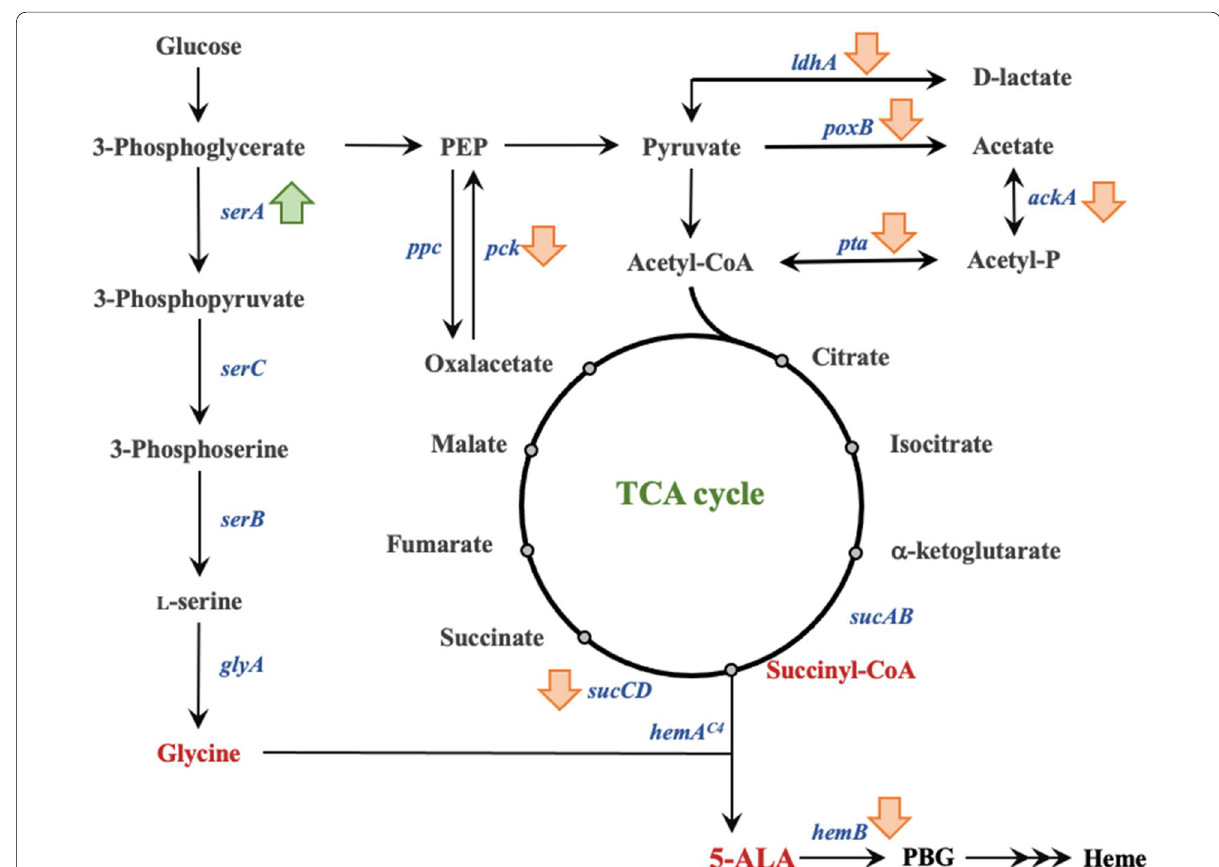
Fig. 1 The C4 pathway for 5‑ALA and heme synthesis. The up and down arrows beside the gene indicate the up‑ or down‑regulation of the gene which can increase 5‑ALA